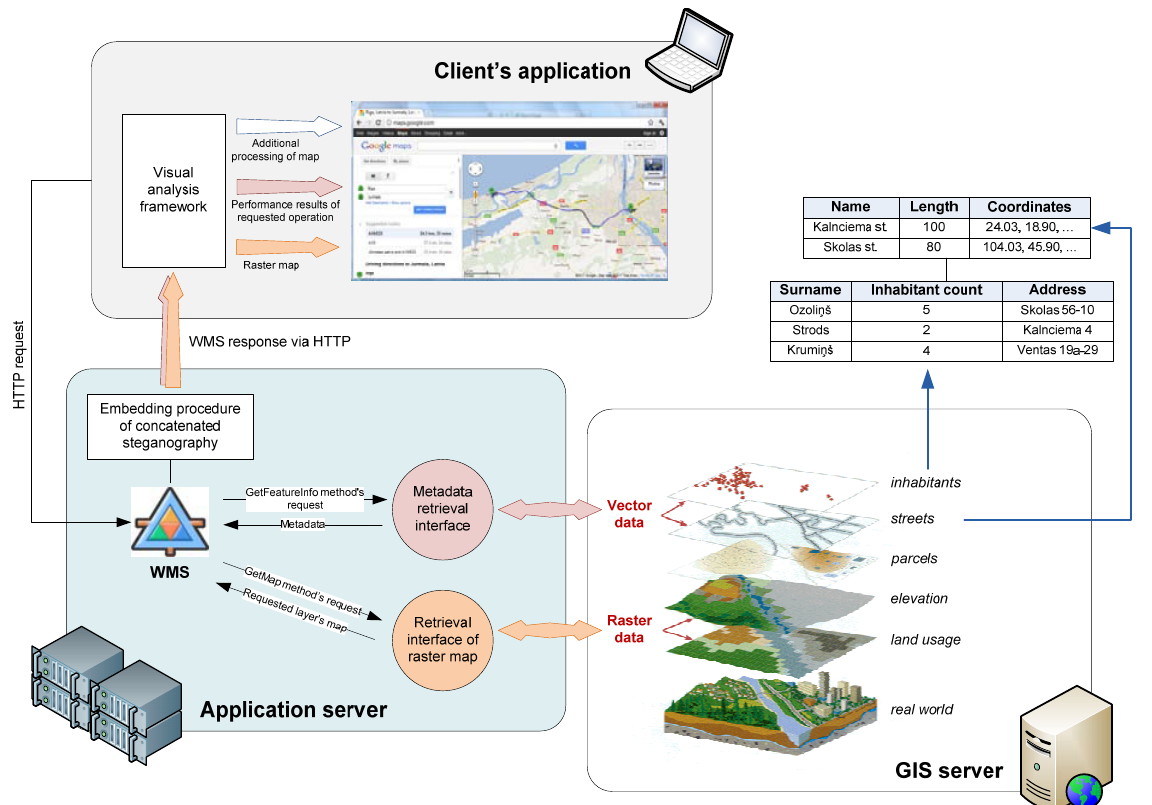
Fig. 4. The data transmission in GIS SOA adapted to visual